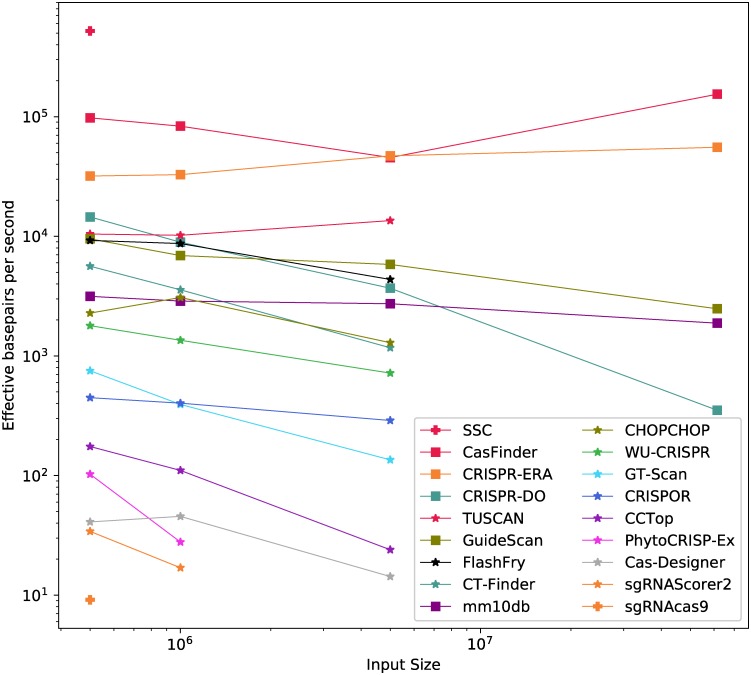
Normalised processing speed.Measured in effective basepairs per second; taking into account the total length of the sequences considered by any given tool. Three performance groups have been identified, and are shown with different symbols for their markers.